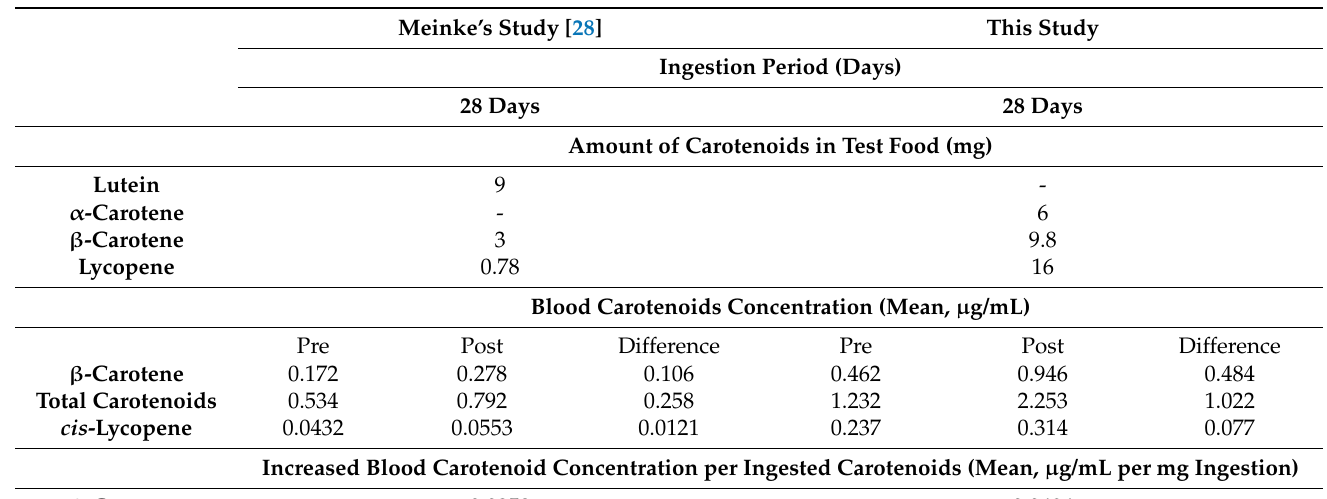
Table 6. Comparison between Meinke’s study and this